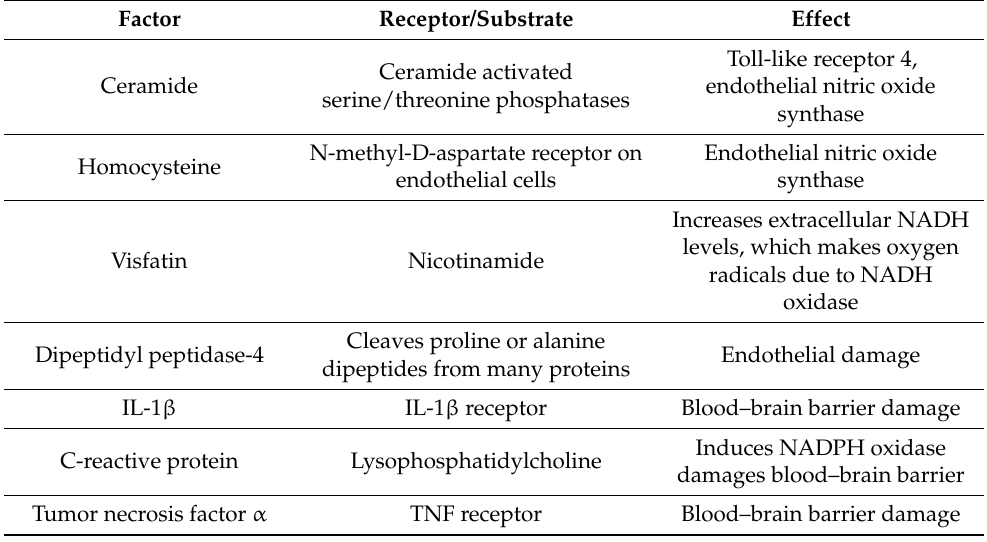
Table 2. Adipokines, homocysteine and ceramide are involved in Alzheimer’s